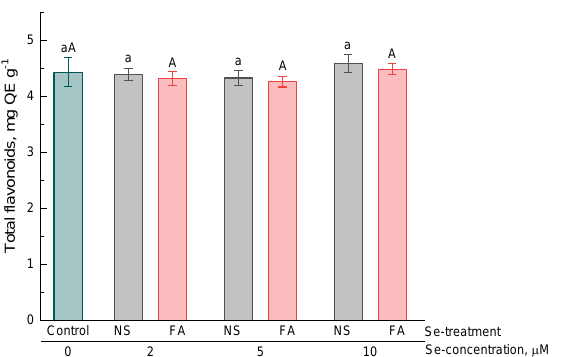
Figure 4. Effect of type and concentration of Se application on total flavonoid content in basil leaves.